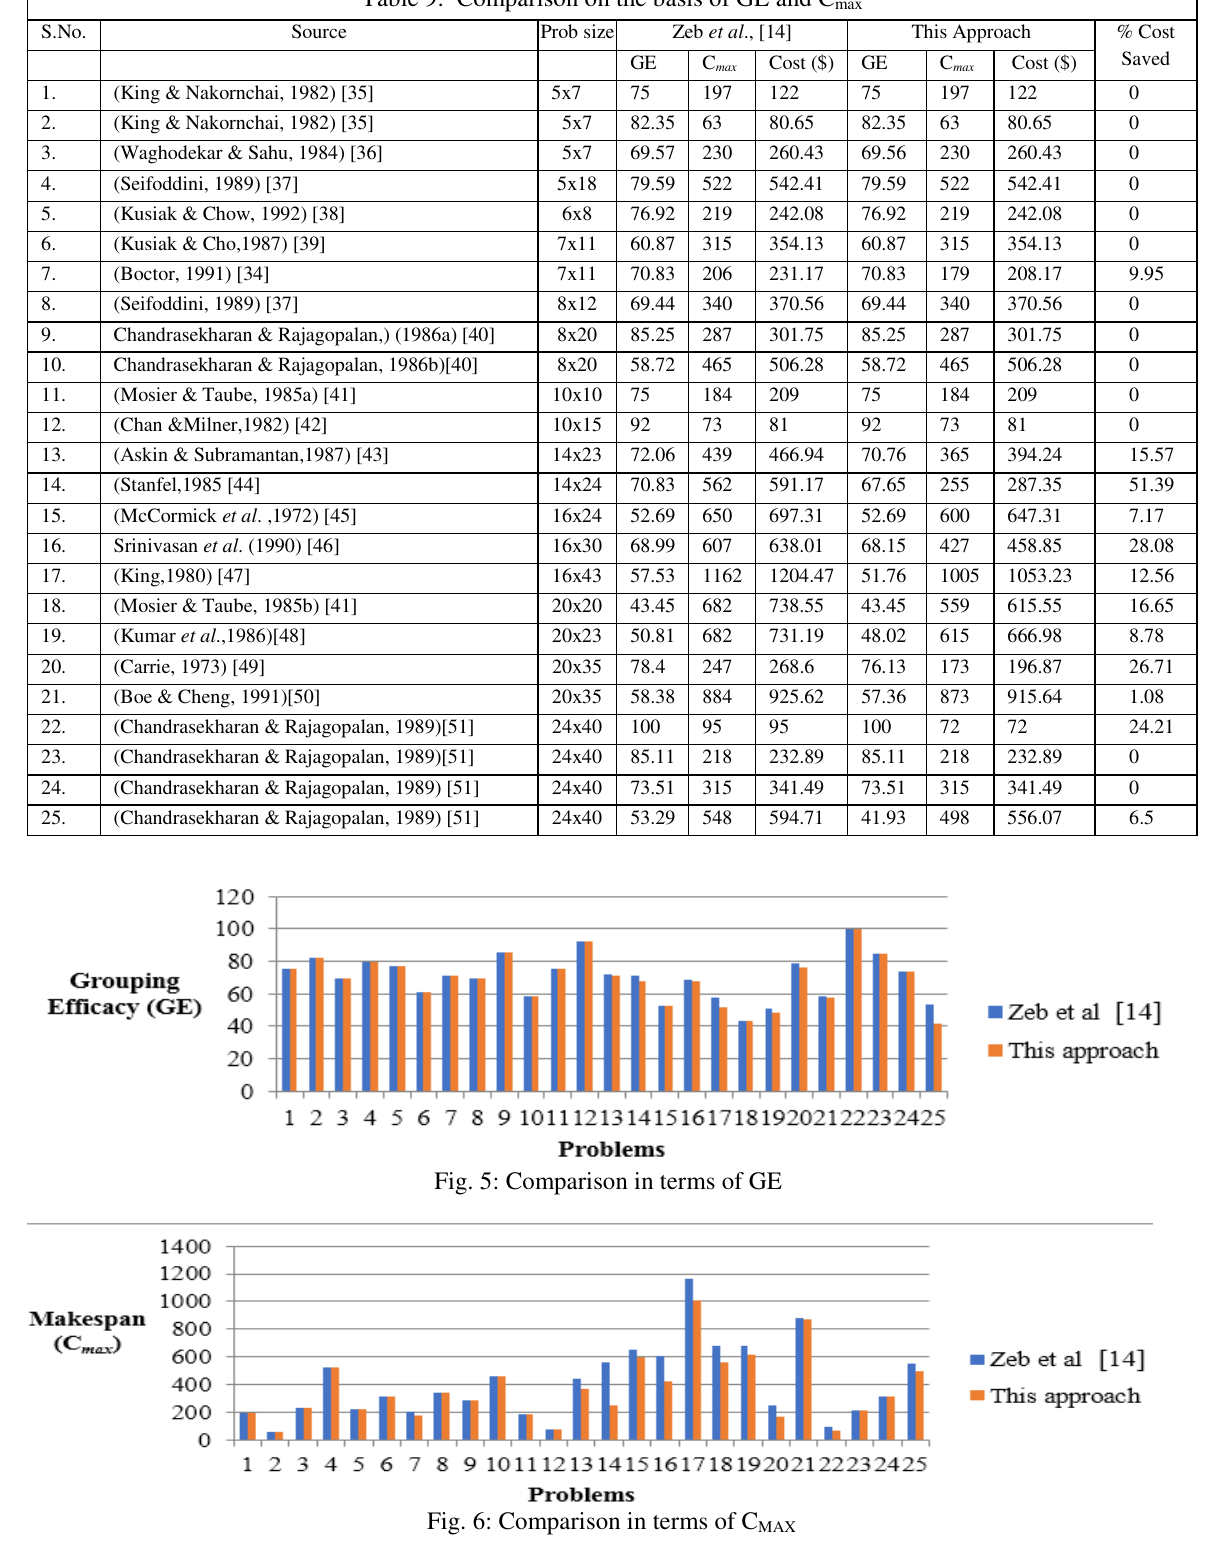
Table 9: Comparison on the basis of GE and C